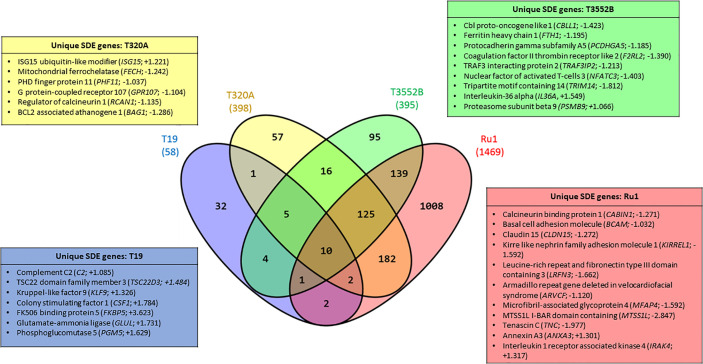
Significantly dysregulated mRNA transcripts common and unique to bovine foot skin fibroblasts challenged with pathogenic and commensal treponemes. Venn diagram illustrating the numbers of mRNA transcripts with common and unique significantly different abundances (FDR-adjusted p value ≤ 0.05, log2 fold change ≥1 and ≤−1) in bovine foot skin fibroblasts challenged with T. medium phylogroup (strain T19), T. phagedenis phylogroup (strain T320A), T. pedis (strain T3552BT) or T. ruminis (strain Ru1T). The total number of significantly dysregulated transcripts per challenge group is given in parentheses under the treponeme strain. A list of several key unique transcripts for each challenge group is given in corresponding colour-coded boxes, alongside their corresponding observed log2 fold changes. Data represents the mean differential mRNA expression of three independent experimental replicates per challenge group (n = 3), with both T. phagedenis and T. ruminis represented by an additional technical replicate (n = 4).